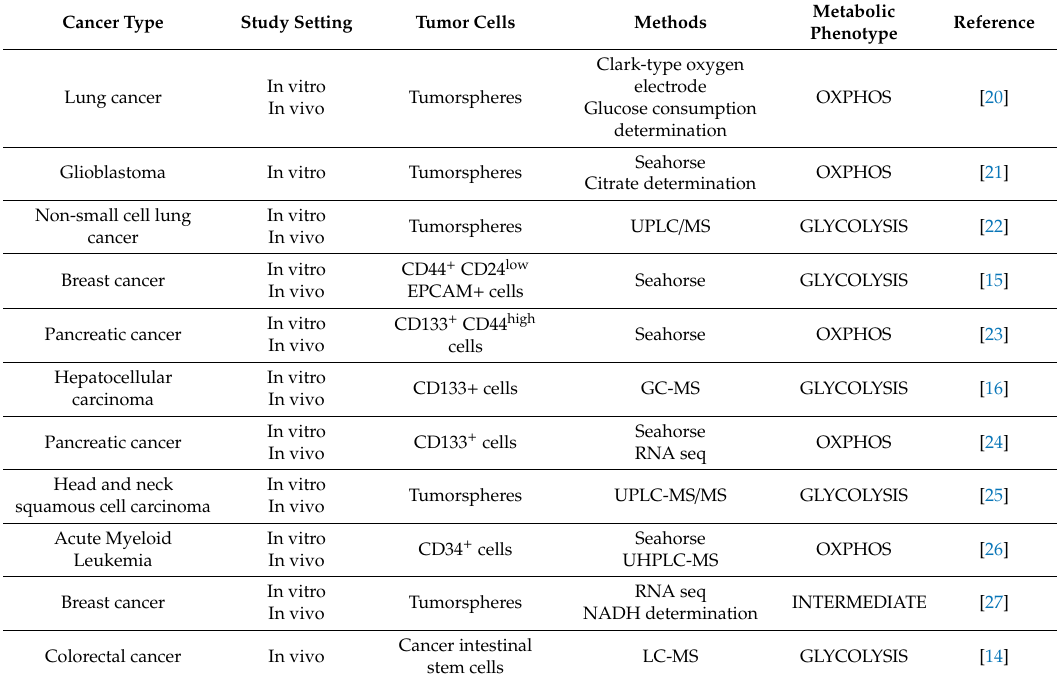
Table 1. Metabolic phenotypes of cancer stem cells in various cancer